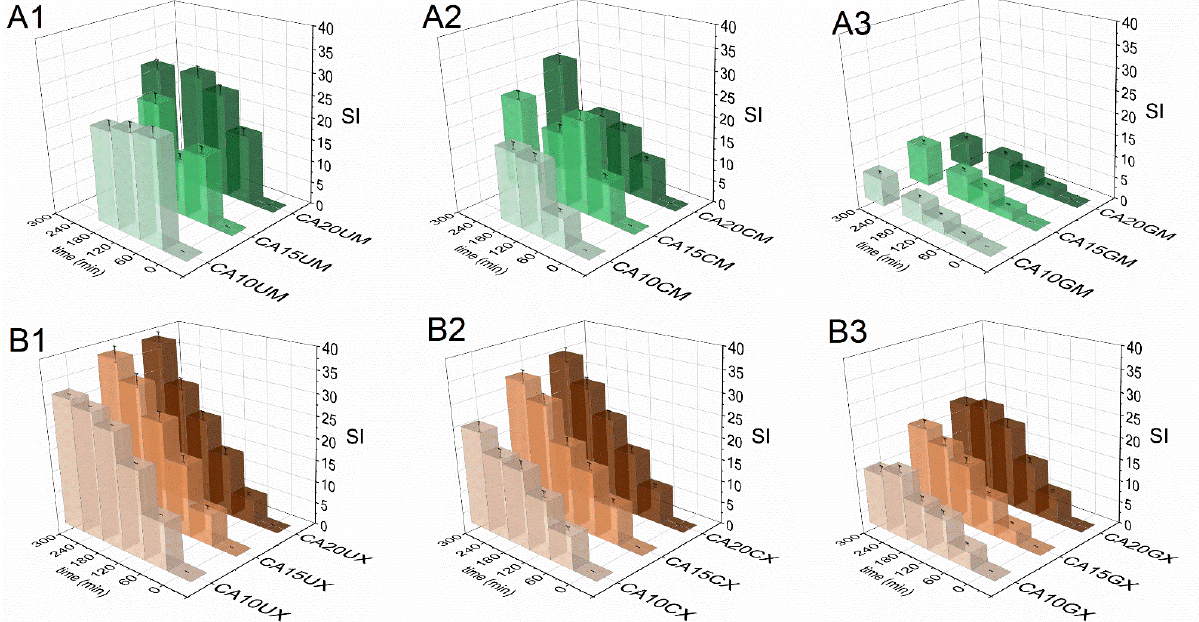
Figure 4. Comparison of the swelling indices (SI) of the CUR-loaded micro- (A1 – A3) and macroparticles (B1 – B3) in Ham’s F-12 medium (see Table 1 for details of the particle composition). The results are presented as the means ± S.D.